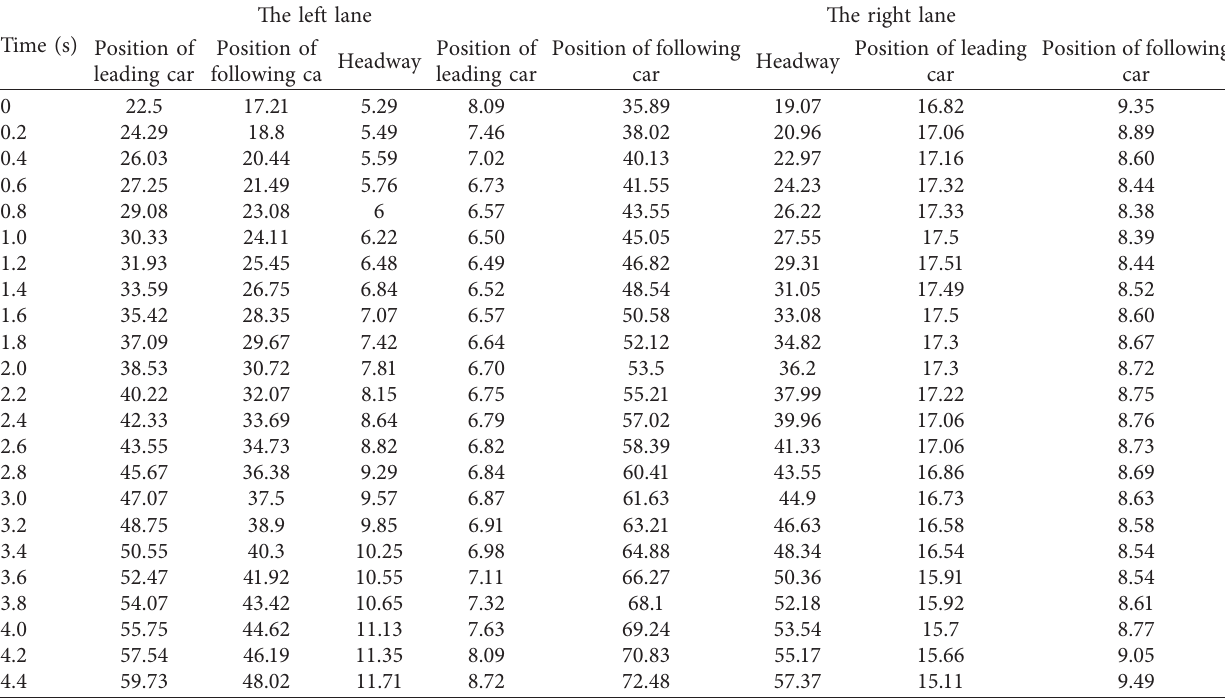
Table 3: The second sets of vehicle